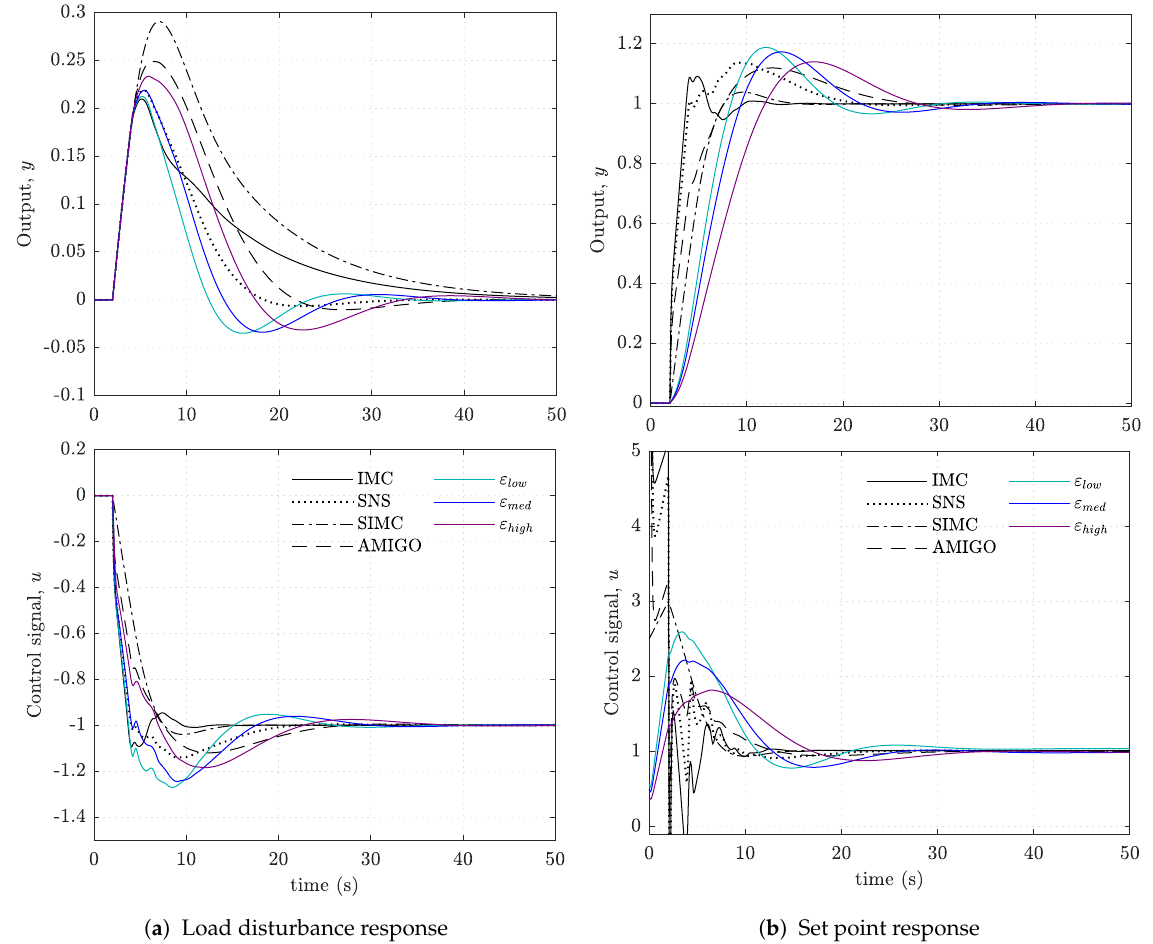
Figure 13. Closed loop time response of G 1 ( s ) with the second-order LADRC tuned with the proposed rules. Comparison with the performance of PID